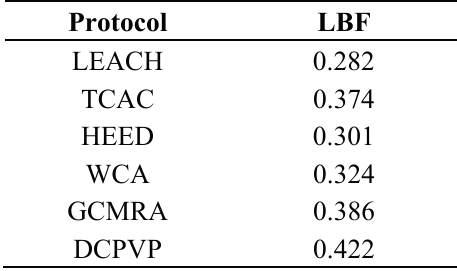
Table 4. The Load Balance Factor for all